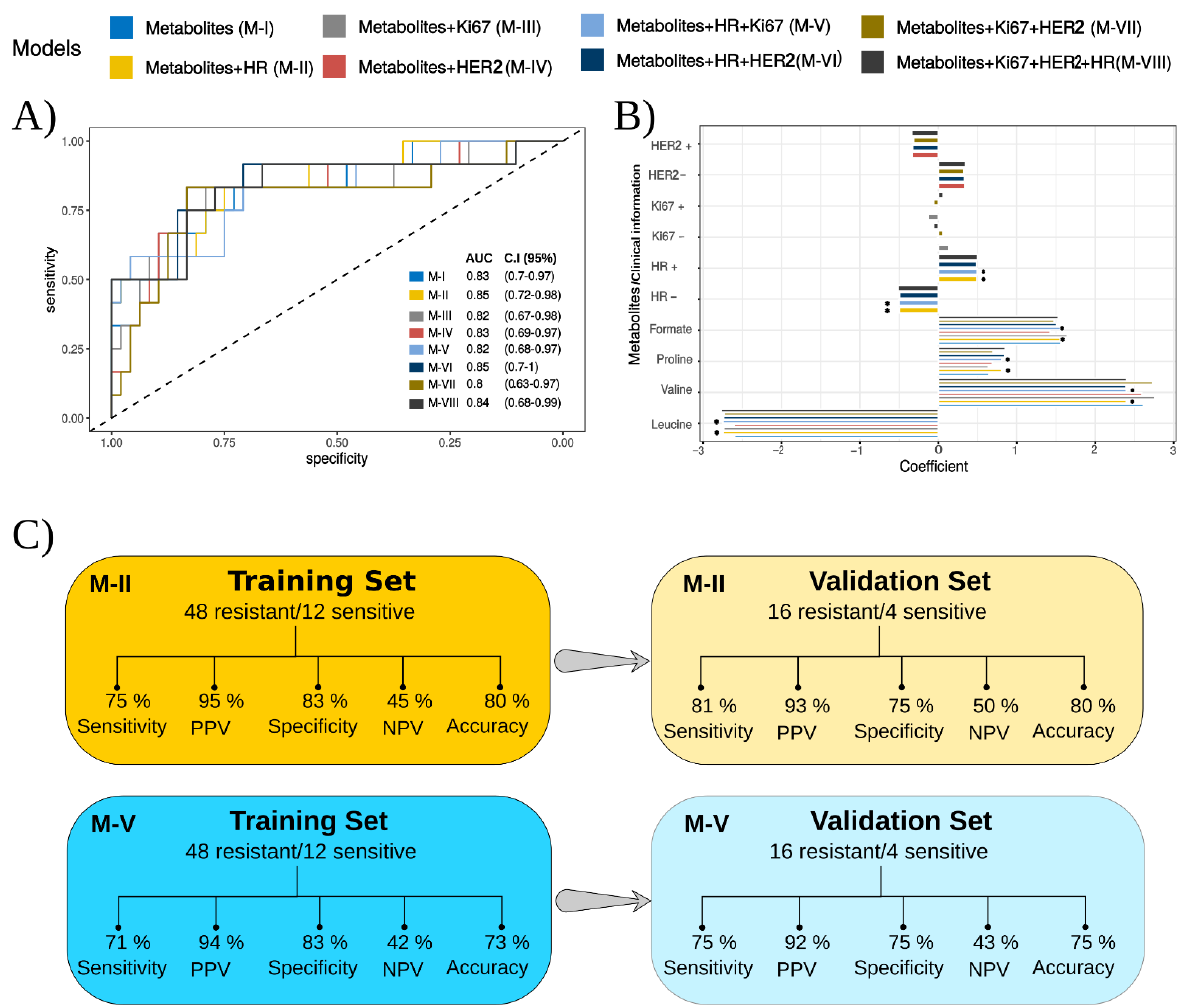
Figure 3. Classification models obtained with the combination of metabolites and clinical information. ( A ) The plot of the ROC curves for each model, containing the area under the curve (AUC). ( B ) The coefficients of the predictors and ( C ) performance of models II and V for training (cross-validation) and validation sets.